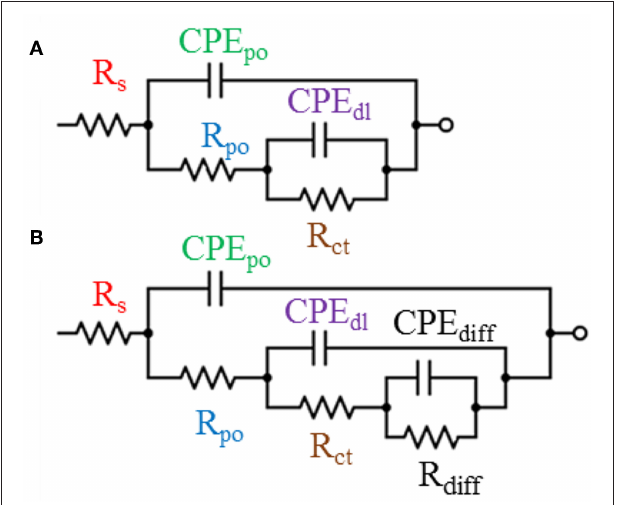
FIGURE 7 | The equivalent circuit models used to perform the fitting for EIS graphs and (A,B) represent the designations of the models that used.